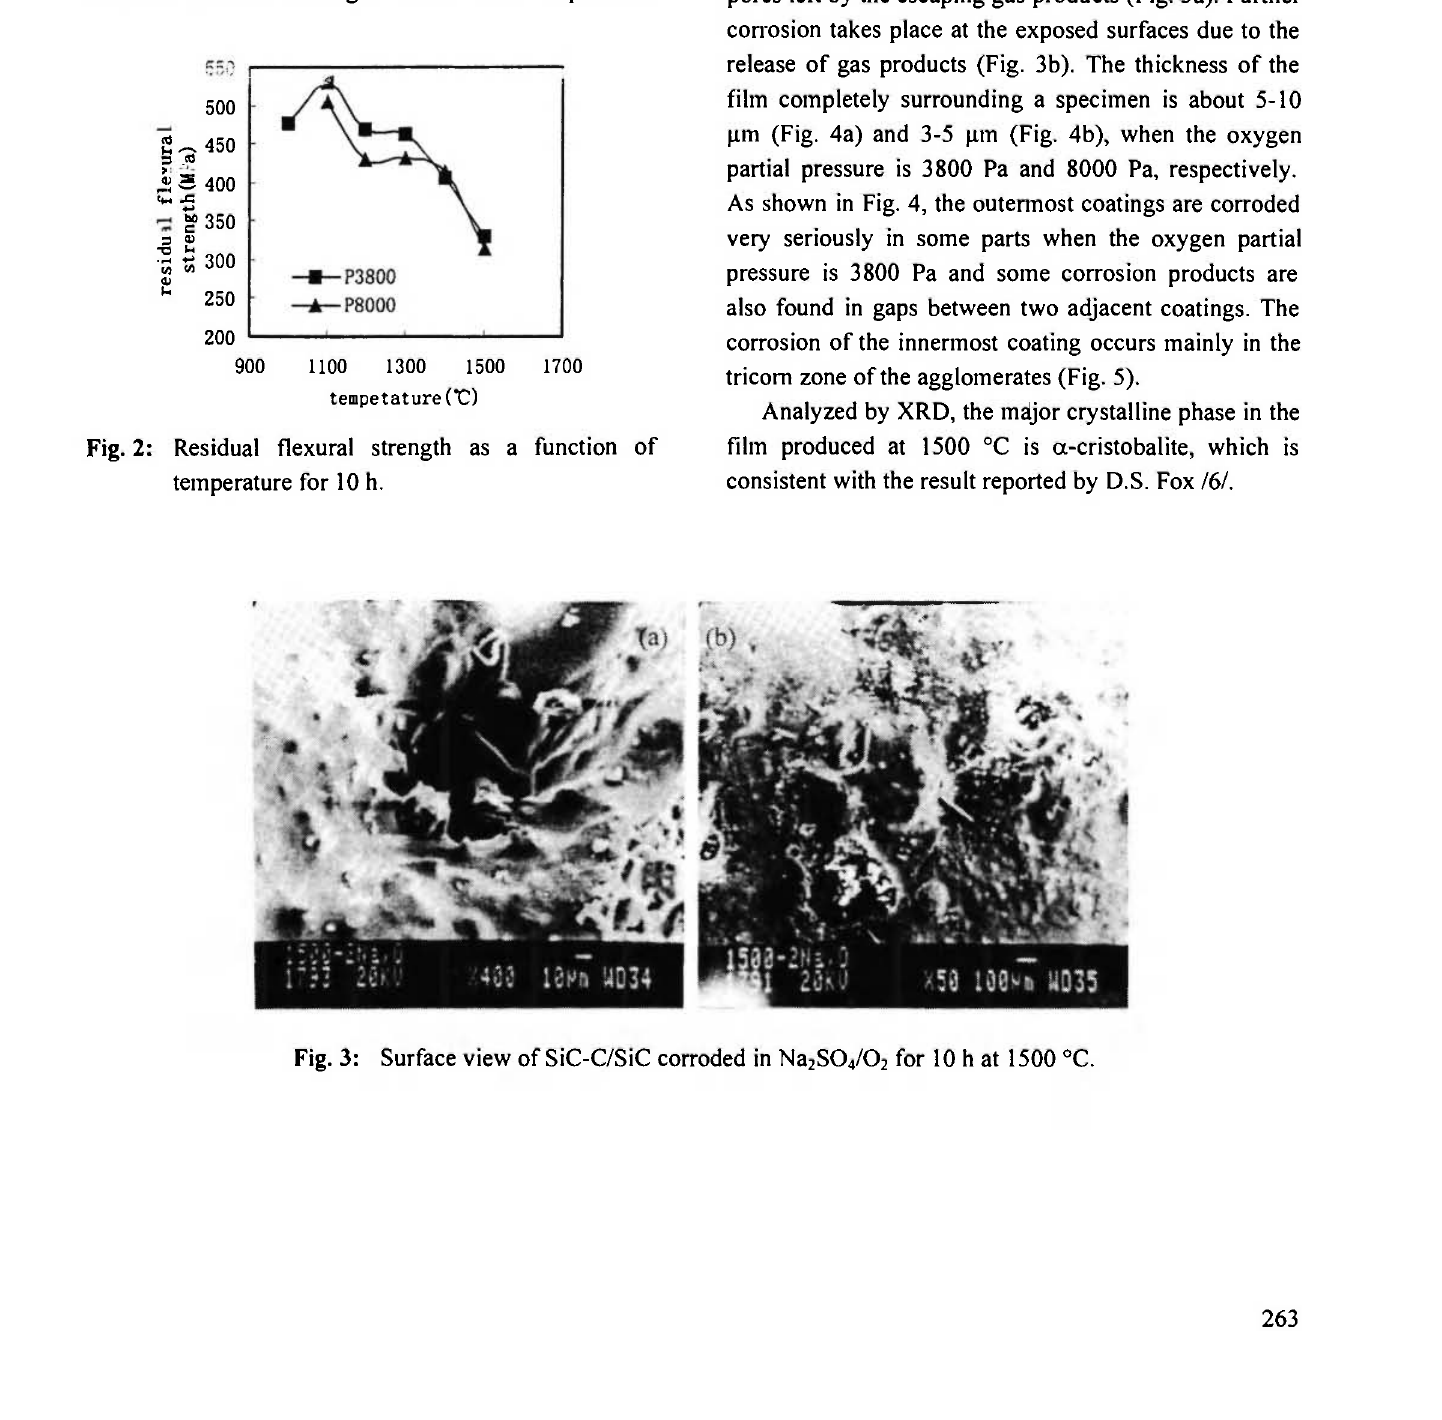
Fig. 3: Surface view of SiC-C/SiC corroded in Na 2 S0 4 /0 2 for 10 h at 1500